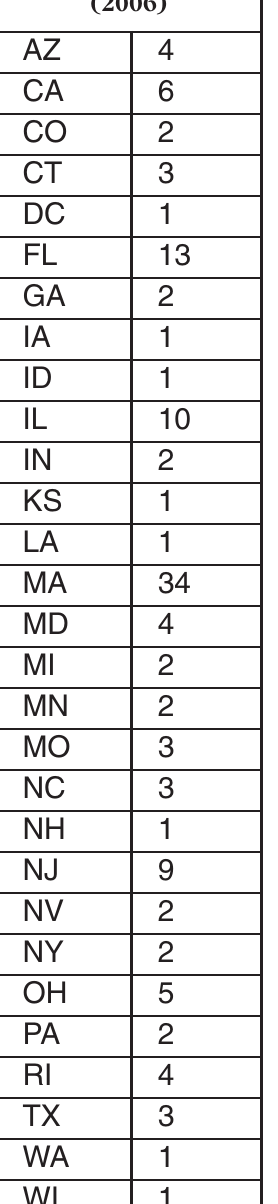
Figure 2. Excerpt from KaBloom’s Employee